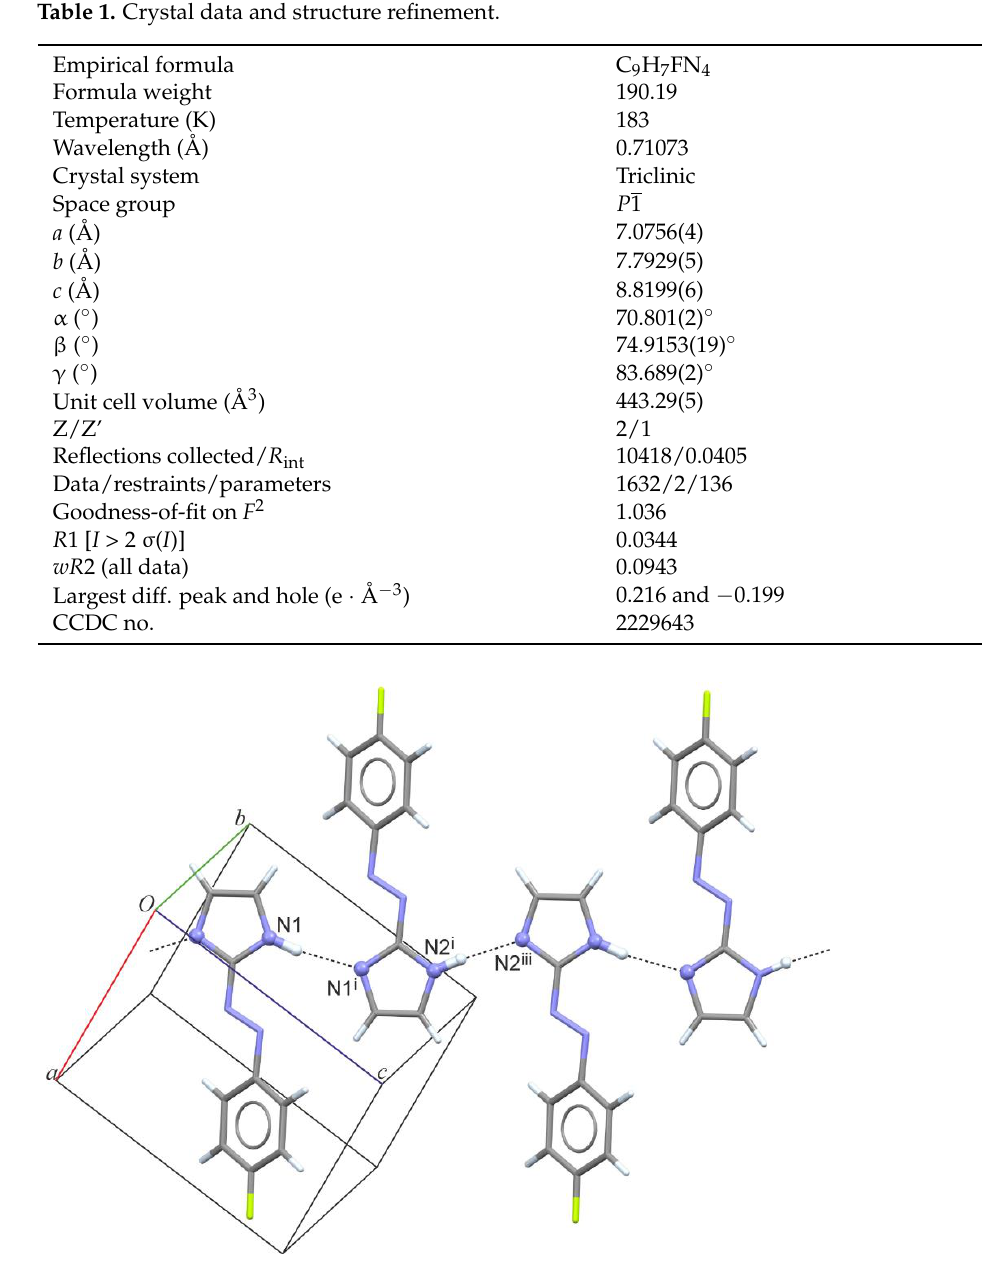
Figure 3. Intermolecular interactions between a central molecule (orange) and two neighboring mol- ecules (blue) belonging to two adjacent molecular layers parallel to the (121) plane. Symmetry codes: (iv) ‒x + 1, ‒y, ‒z + 1; (v) ‒x + 1, ‒y + 1, ‒z + 1. Table 2 . Hydrogen-bond geometry (Å , °). D ‒H··· A